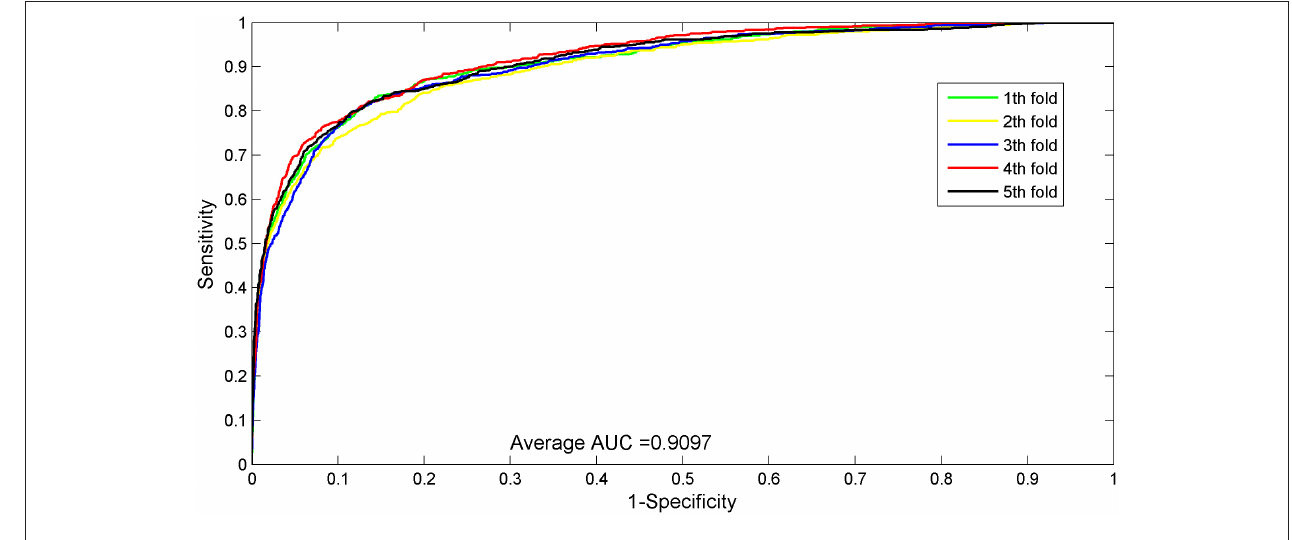
FIGURE 2 | ROC curves for five-fold cross-validation tests of the benchmark dataset.